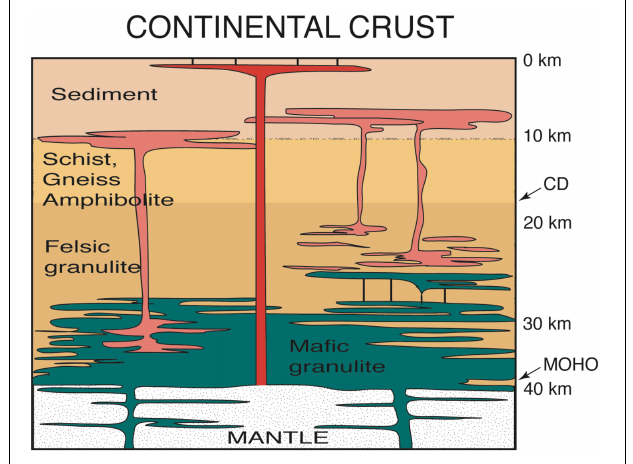
FIGURE 8 | Schematic sketch section through the continental crust, initially drawn by Tony Kemp (Hawkesworth and Kemp,